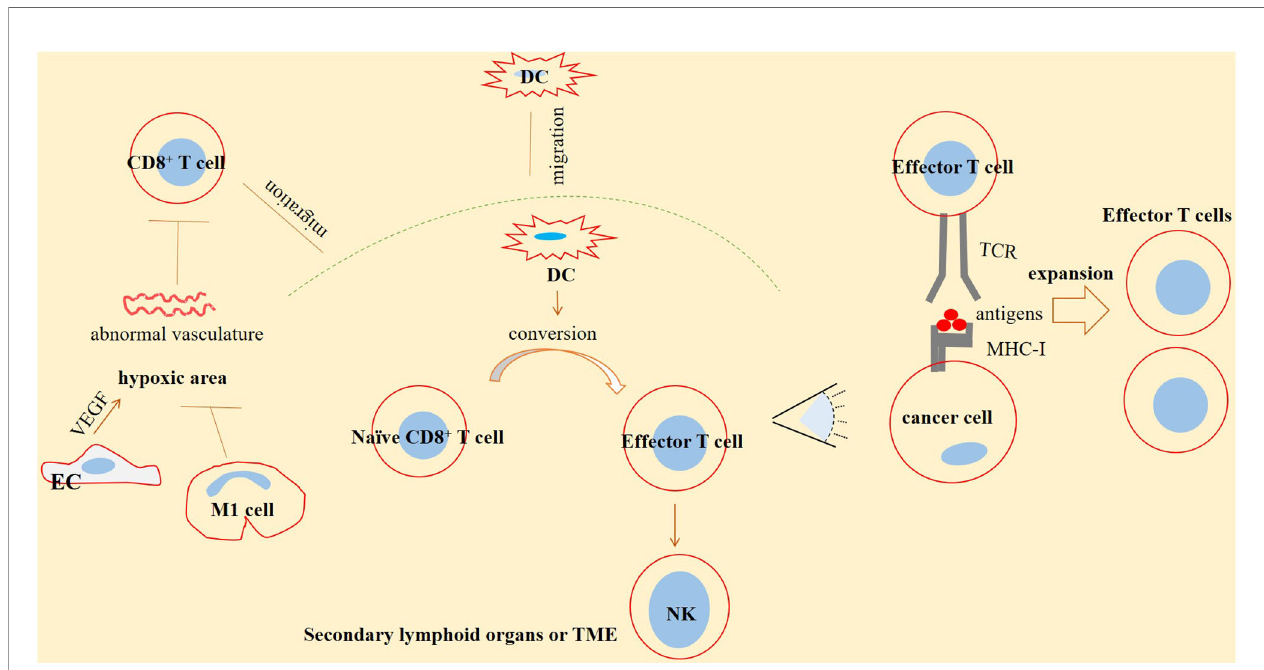
FIGURE 1 | CD8 + T-cell in fi ltration and effector function against cancer. CD8 + T cells are in fi ltrated into the tumor microenvironment (TME) and secondary lymphoid organs. Here, CD8 + T cells are converted into effector T cells under exposure to dendritic cells (DCs) migrated toward the area and form a functional circuity with DCs and natural killer (NK) cells. A normal vasculature is an inducer of CD8 + T-cell migration toward the tumor area. Generally, tumor vasculature is abnormal in solid cancers, especially in advanced stages, which is a reason for higher immune escape and resistance. High vascular endothelial growth factor (VEGF) release from endothelial cells (ECs) is a key promoter of such abnormality. High VEGF is linked with hypoxia and a leaky vasculature. Macrophage type 1 (M1) cells are antitumor cells of TME that are acting for strengthening immune effector function through promoting vascular normality. T-cell receptors (TCRs) expressed on in fi ltrated CD8 + T cells are able to detect antigens bounded to the major histocompatibility complex-1 (MHC-1), expressed on the surface of tumor cells, a result of which is the expansion of effector T cells able to act against